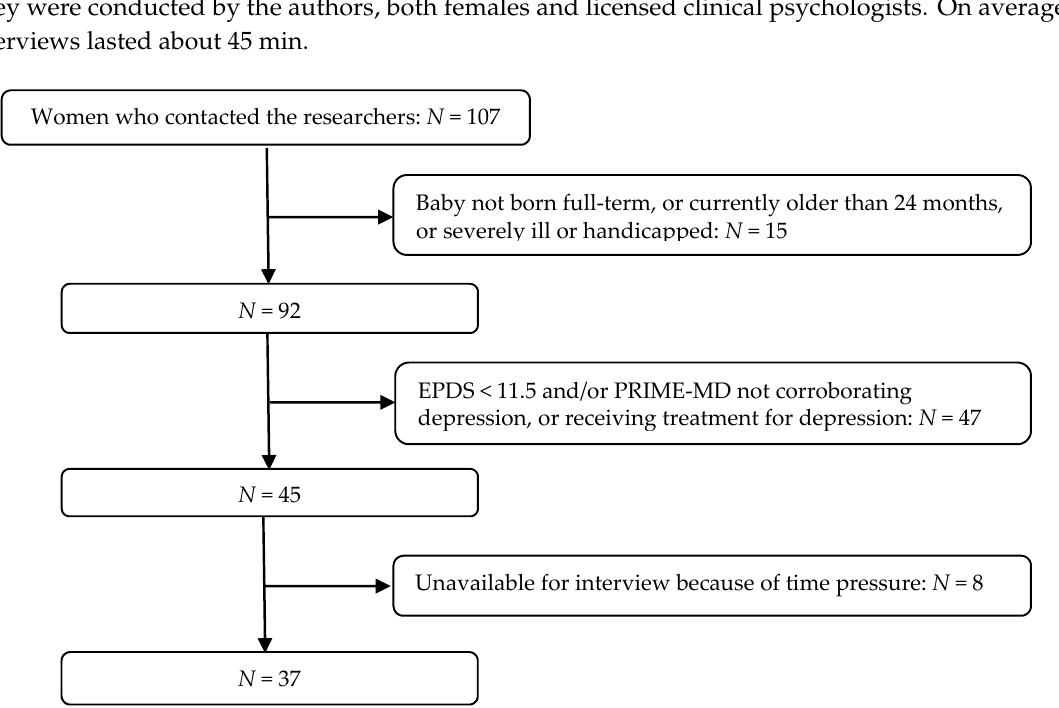
Figure 1. Recruitment procedure steps and total sample. Note: EPDS: Edinburg Postpartum Depression Scale; PRIME-MD: Primary Care Evaluation of Mental Disorders, see Measures,